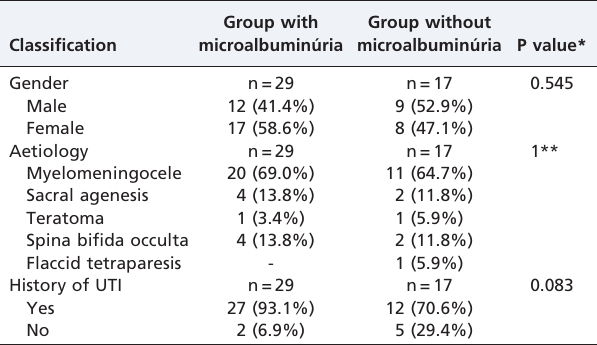
microalbuminuria and the group with microalbuminu´ ria regarding gender, etiology of neurogenic bladder